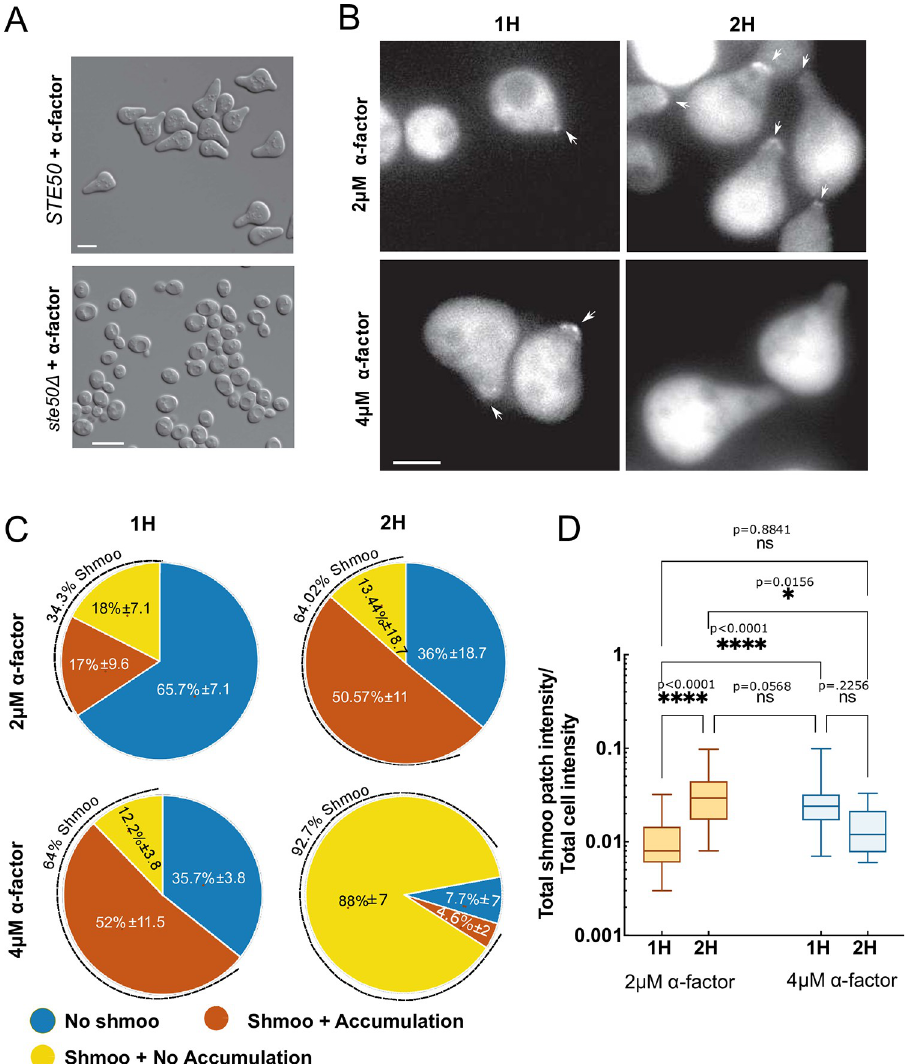
Fig 1. Pheromone concentration-dependent Ste50p shmoo tip localization ste50 Δ strain, with or without Ste50-GFP on a plasmid, was treated with α -factor and imaged using epifluorescence and DIC microscopy. (A) Response of STE50 as indicated after 4h treatment with 2 μ M α -factor. (B) Ste50p patch localization at the shmoo tip at the indicated concentrations of α -factor for the indicated time. (C) Number of cells with localized Ste50p polarity patches at the shmoo tip at the indicated pheromone concentrations and time (n � 100 cells, N = 3). (D) Quantified polarity patches of Ste50p at the shmoo tip with respect to the cytoplasmic amount at indicated pheromone concentrations and time (see text); N = 2: 2 μ M 1h (mean = 0.01, SD ± 0.0064; n = 35), 2 μ M 2h (mean = 0.035, SD ± 0.0224; n = 75), 4 μ M 1h (mean = 0.028, SD ± 0.0163; n = 78), 4 μ M 2h (mean = 0.015, SD ± 0.0091; n = 8); ���� , p < 0.0001; ns = not significant; p > 0.05; one-way Anova with Tukey’s multiple comparisons. Bar represents 5 μ m.